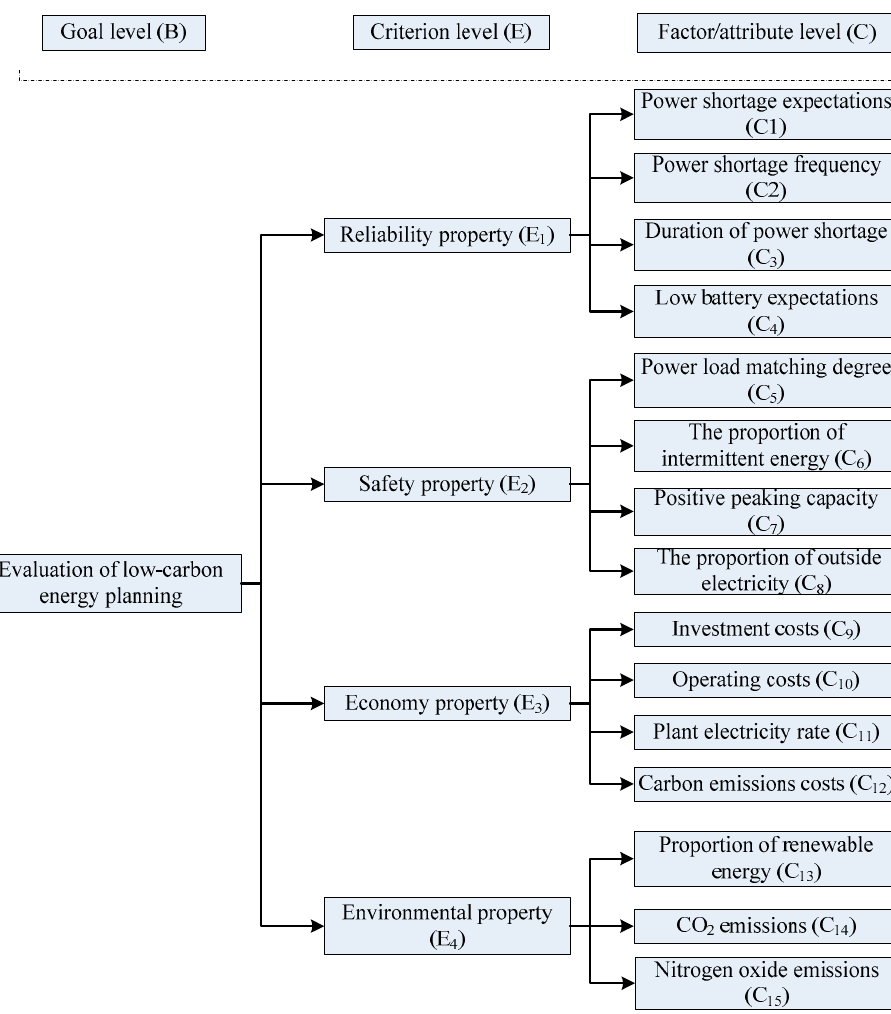
Figure 1. A hierarchy structure for the evaluation of low-carbon energy planning.